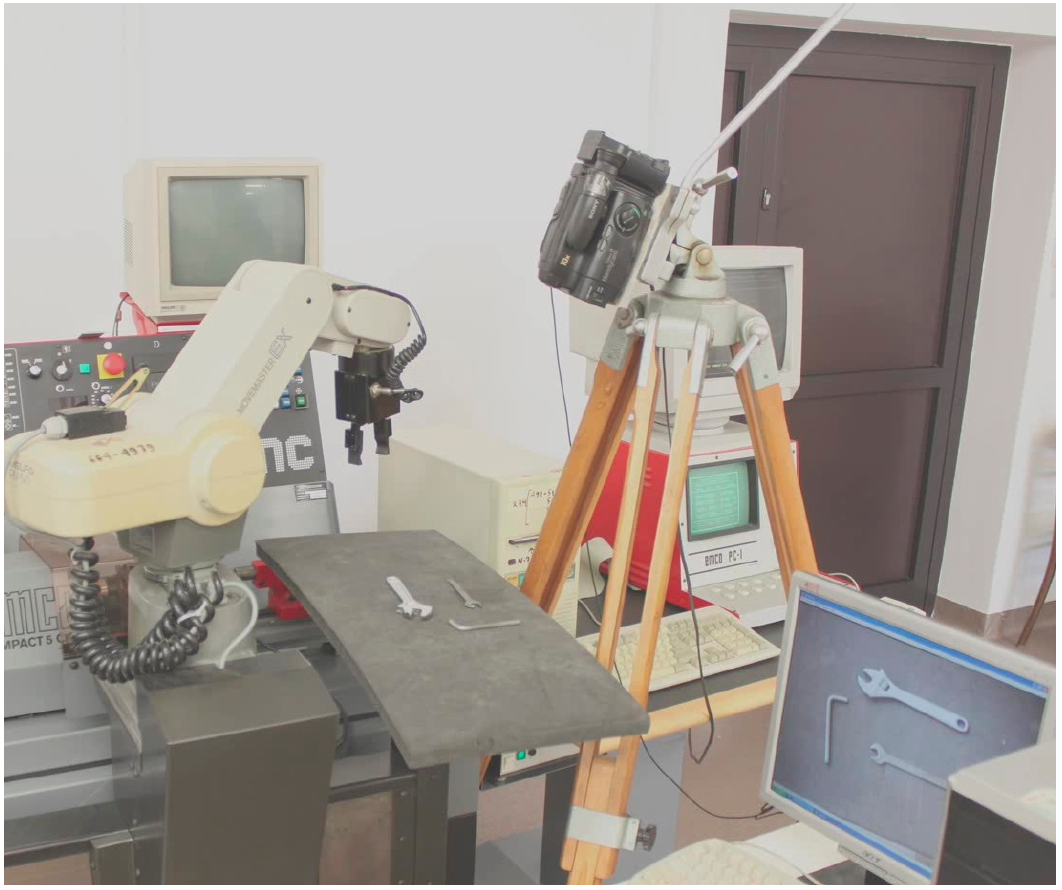
Figure 6. Robotized machining cell equipped with speech and image recognition systems.